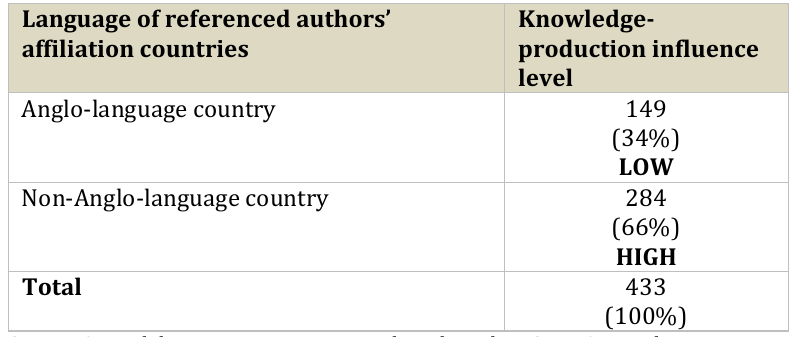
Table 7: Level of knowledge-production influence in Crimes of the powerful studies in LAC according to the referenced authors’ affiliation country language (SciELO search, 14 articles, n=433